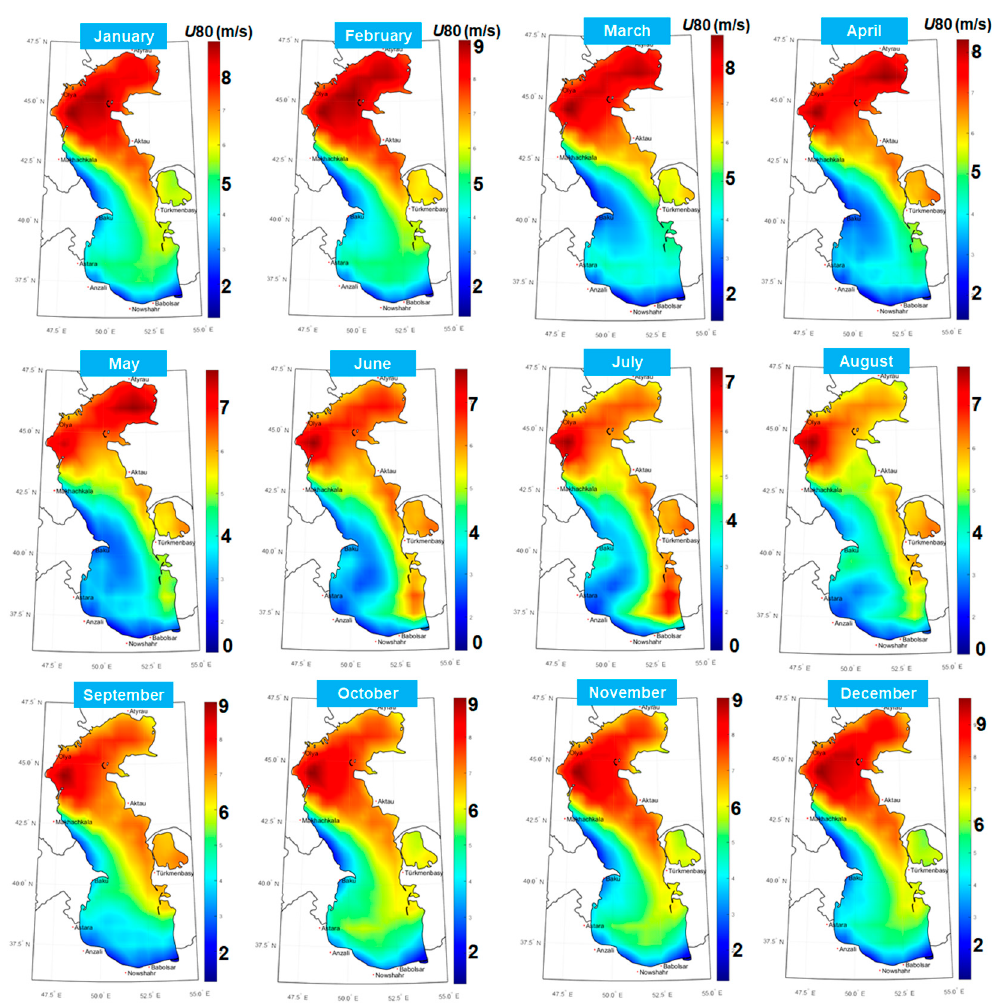
Figure 6. Monthly distribution of the U 80 parameter (average values) reported by the ERA-Interim wind data for the 20-year time interval from January 1999 to December 2018.